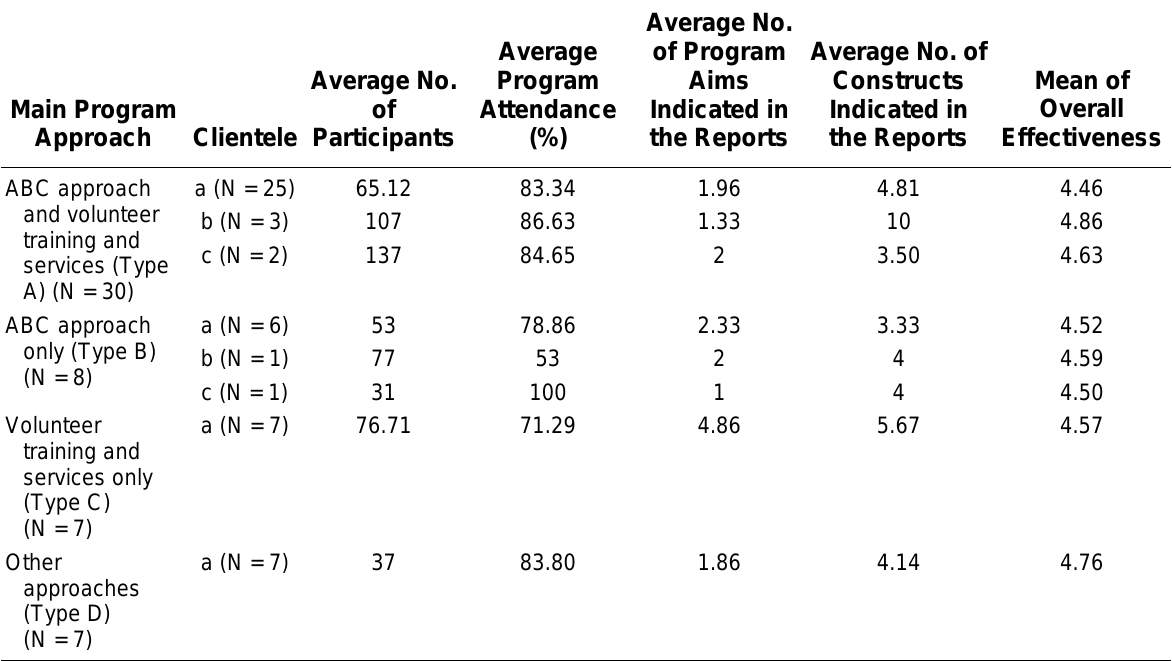
Summary Program Characteristics and